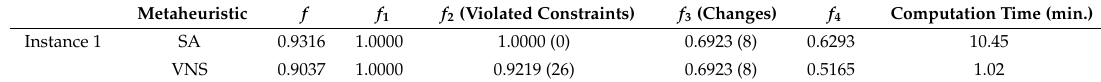
Figure 12. Optimal solution derived from Phase 2 using variable neighborhood search (VNS). Table 1. Results for Instance 1 using SA and